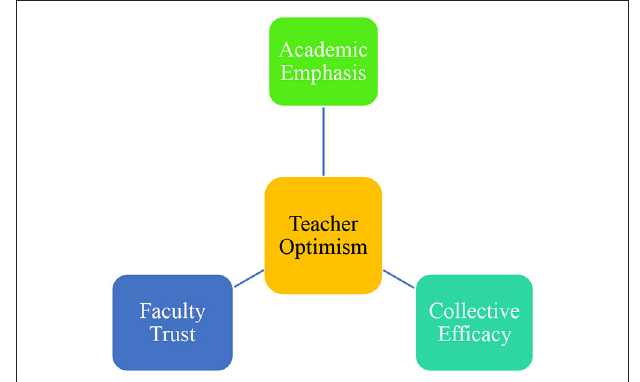
FIGURE 1 | The dimensions of teacher optimism (Hoy et al.,